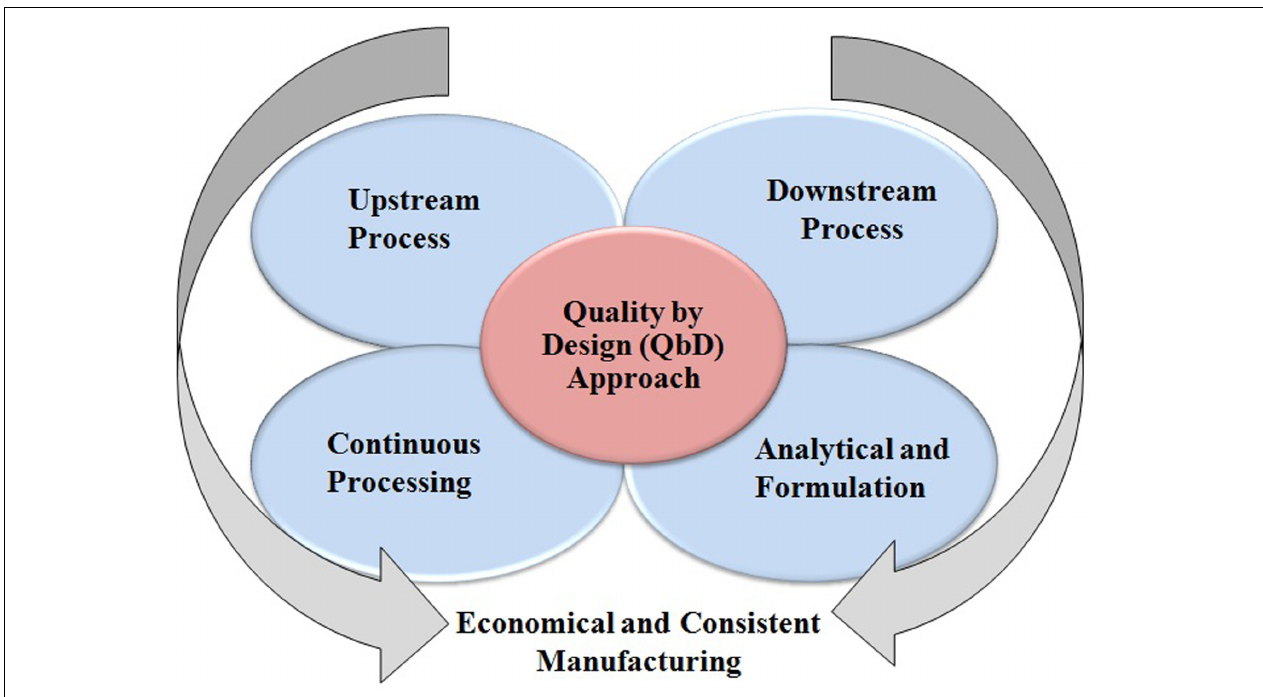
FIGURE 1 | Implementation of QbD approach for the production of therapeutic drugs.